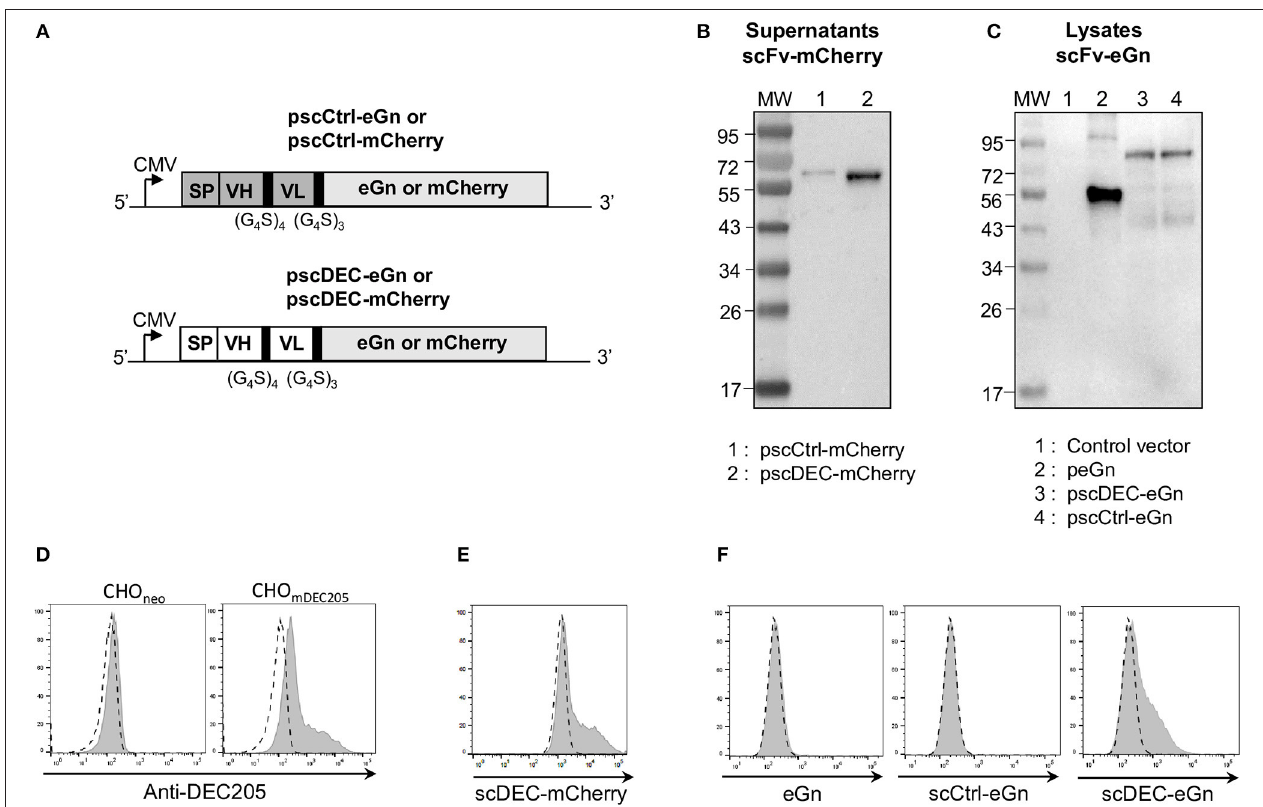
FIGURE 2 | Design and characterization of the pscCtrl or pscDEC plasmids encoding the eGn and mCherry protein fusions with scFvs. (A) Schematic representation of pscCtrl and pscDEC fused with eGn or mCherry sequences. The pscCtrl (gray background) and pscDEC (white background) constructions include the signal peptide from VH of murine IgG (SP), the scFv (VH and VL) sequences, and the codon-optimized eGn or the mCherry sequences. The VH and VL sequences derived from the rat anti-DEC205 NLDC-145 mAb (scDEC) and from a control rat mAb (scCtrl) are connected together with a (G 4 S) 4 linker and the scFv and antigen sequences are connected with a (G 4 S) 3 linker. In (B) purified scCtrl-mCherry and scDEC-mCherry proteins collected from supernatants of transfected HEK293 cells were separated by SDS-PAGE under reducing conditions and mCherry was revealed with an anti-mCherry rabbit IgG followed by a HRP-GAR IgG. The predicted sizes of the expressed chimeric proteins are 57.6 and 57.5 kDa for the scDEC-mCherry and scCtrl-mCherry, respectively. In (C) HEK293 cells were transfected with pcDNA4 (control), peGn, pscCtrl-eGn, and pscDEC-eGn. The cell lysates were separated by SDS-PAGE under reducing conditions and eGn was revealed with an anti-RVFV HMAF followed by a HRP-GAM IgG. The predicted sizes of the recombinant proteins are 48.8 kDa for eGn, 78.8 kDa for the scCtrl-eGn, and 79 kDa for the scDEC-eGn. In (D) CHO cells expressing the murine DEC205 receptor (CHO mDEC205 ) or CHO neo (control) were labeled with 10 µ g/ml of A647-anti-DEC205 (gray) and compared to an A647-isotype control (dash line). In (E) CHO mDEC205 were labeled with 50 µ g/ml of scCtrl-mCherry and scDEC-mCherry proteins from purified supernatants. The staining with scDEC-mCherry is depicted (gray) and compared to scCtrl-mCherry (dash line). In (F) CHO mDEC205 were labeled with the 20–40 times concentrated supernatants from the same number of transfected cells with peGn, pscCtrl-eGn, and pscDEC-eGn and eGn was revealed with the RVFV HMAF (1:1,000) followed with an A488-DAM IgG. The staining is depicted (gray) compared to a control supernatant (pcDNA4 empty vector, dash line). No signal was obtained with CHO neo cells (not